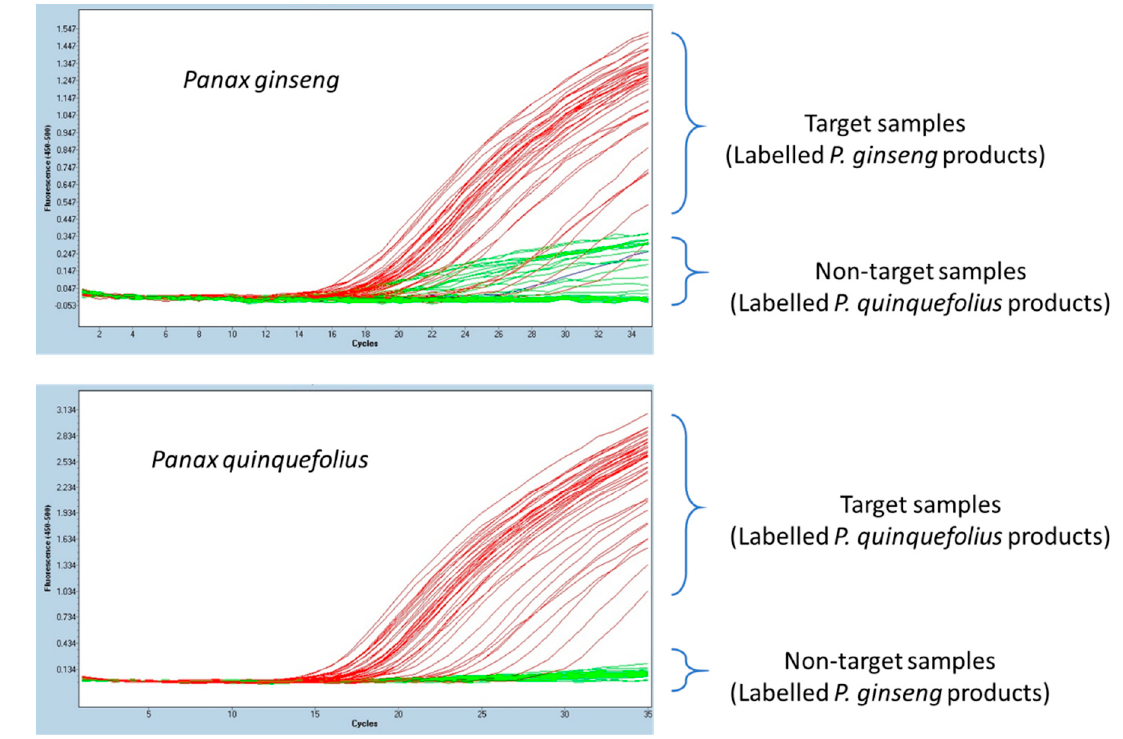
Figure 3. Authentication of commercially labelled ginseng samples with Panax ginseng and Panax quinquefolius assays using LightCycler ® 480 Instrument. A total of 82 samples of known provenance collected from NHPRA members were tested with each assay.